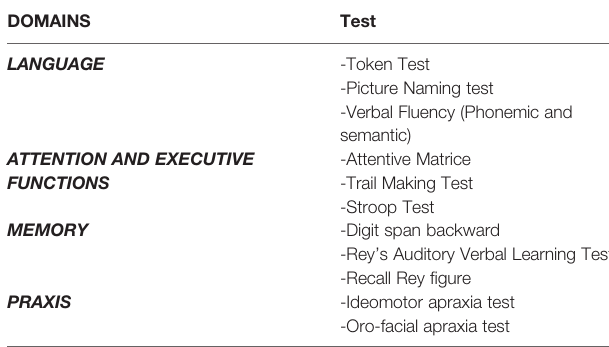
TABLE 2 | Neuropsychological